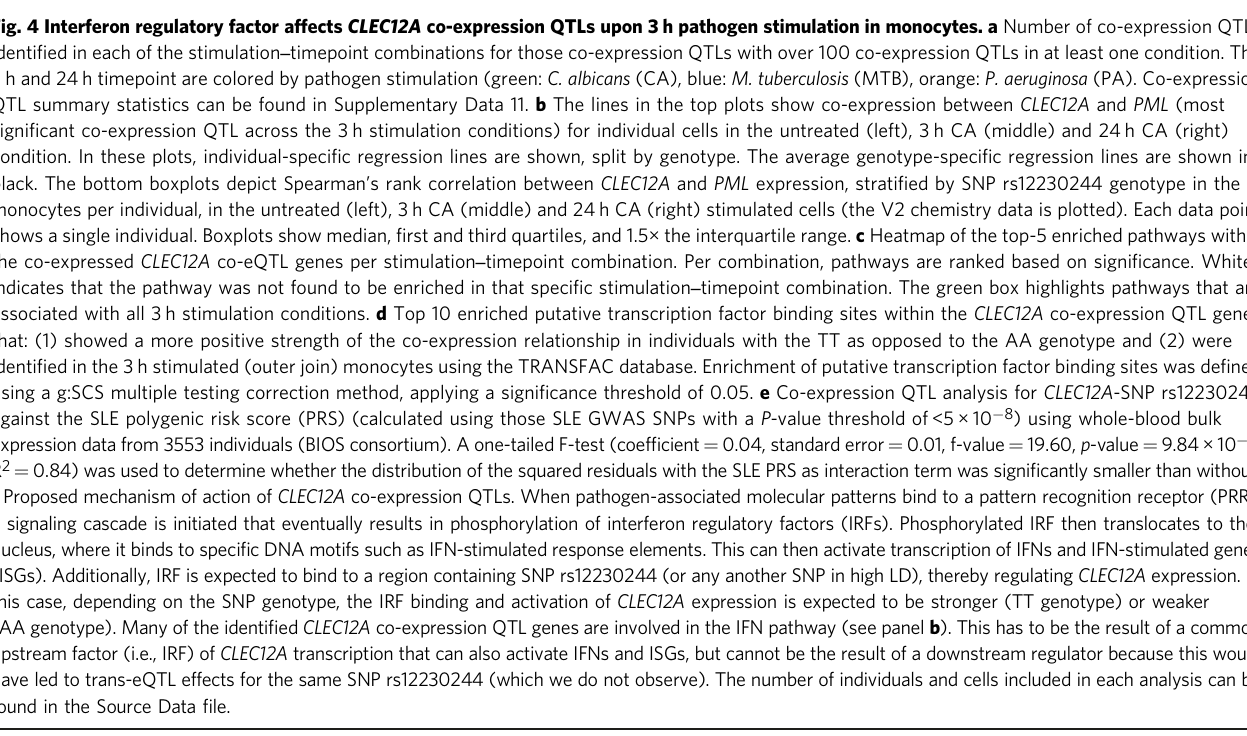
Fig. 4 Interferon regulatory factor affects CLEC12A co-expression QTLs upon 3 h pathogen stimulation in monocytes. a Number of co-expression QTLs identi fi ed in each of the stimulation ‒ timepoint combinations for those co-expression QTLs with over 100 co-expression QTLs in at least one condition. The 3 h and 24 h timepoint are colored by pathogen stimulation (green: C. albicans (CA), blue: M. tuberculosis (MTB), orange: P. aeruginosa (PA). Co-expression QTL summary statistics can be found in Supplementary Data 11. b The lines in the top plots show co-expression between CLEC12A and PML (most signi fi cant co-expression QTL across the 3 h stimulation conditions) for individual cells in the untreated (left), 3 h CA (middle) and 24 h CA (right) condition. In these plots, individual-speci fi c regression lines are shown, split by genotype. The average genotype-speci fi c regression lines are shown in black. The bottom boxplots depict Spearman ’ s rank correlation between CLEC12A and PML expression, strati fi ed by SNP rs12230244 genotype in the monocytes per individual, in the untreated (left), 3 h CA (middle) and 24 h CA (right) stimulated cells (the V2 chemistry data is plotted). Each data point shows a single individual. Boxplots show median, fi rst and third quartiles, and 1.5× the interquartile range. c Heatmap of the top-5 enriched pathways within the co-expressed CLEC12A co-eQTL genes per stimulation ‒ timepoint combination. Per combination, pathways are ranked based on signi fi cance. White indicates that the pathway was not found to be enriched in that speci fi c stimulation ‒ timepoint combination. The green box highlights pathways that are associated with all 3 h stimulation conditions. d Top 10 enriched putative transcription factor binding sites within the CLEC12A co-expression QTL genes that: (1) showed a more positive strength of the co-expression relationship in individuals with the TT as opposed to the AA genotype and (2) were identi fi ed in the 3 h stimulated (outer join) monocytes using the TRANSFAC database. Enrichment of putative transcription factor binding sites was de fi ned using a g:SCS multiple testing correction method, applying a signi fi cance threshold of 0.05. e Co-expression QTL analysis for CLEC12A -SNP rs12230244 against the SLE polygenic risk score (PRS) (calculated using those SLE GWAS SNPs with a P -value threshold of <5 × 10 − 8 ) using whole-blood bulk expression data from 3553 individuals (BIOS consortium). A one-tailed F-test (coef fi cient = 0.04, standard error = 0.01, f-value = 19.60, p -value = 9.84×10 − 6 , R 2 = 0.84) was used to determine whether the distribution of the squared residuals with the SLE PRS as interaction term was signi fi cantly smaller than without. f Proposed mechanism of action of CLEC12A co-expression QTLs. When pathogen-associated molecular patterns bind to a pattern recognition receptor (PRR), a signaling cascade is initiated that eventually results in phosphorylation of interferon regulatory factors (IRFs). Phosphorylated IRF then translocates to the nucleus, where it binds to speci fi c DNA motifs such as IFN-stimulated response elements. This can then activate transcription of IFNs and IFN-stimulated genes (ISGs). Additionally, IRF is expected to bind to a region containing SNP rs12230244 (or any another SNP in high LD), thereby regulating CLEC12A expression. In this case, depending on the SNP genotype, the IRF binding and activation of CLEC12A expression is expected to be stronger (TT genotype) or weaker (AA genotype). Many of the identi fi ed CLEC12A co-expression QTL genes are involved in the IFN pathway (see panel b ). This has to be the result of a common upstream factor (i.e., IRF) of CLEC12A transcription that can also activate IFNs and ISGs, but cannot be the result of a downstream regulator because this would have led to trans-eQTL effects for the same SNP rs12230244 (which we do not observe). The number of individuals and cells included in each analysis can be found in the Source Data fi